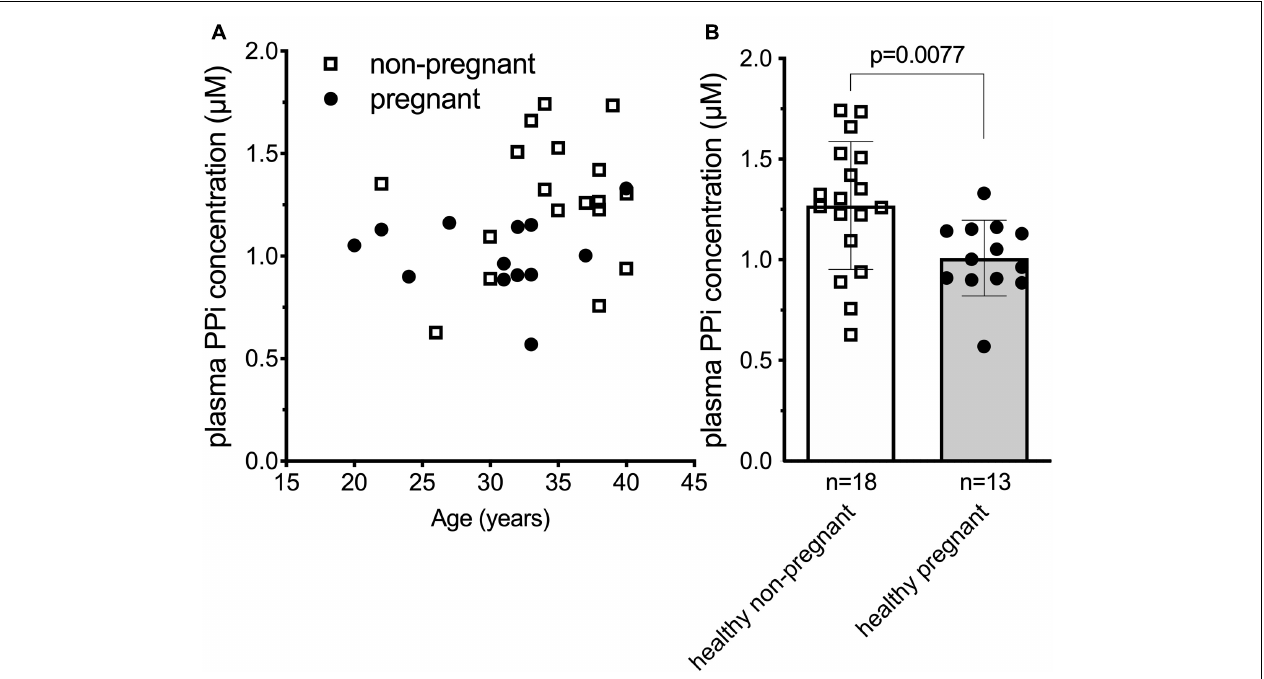
FIGURE 2 | Plasma inorganic pyrophosphate concentration is significantly decreased in uncomplicated human pregnancy. (A) Plasma inorganic pyrophosphate concentration versus age in pregnant ( n = 13, closed circles) and non-pregnant ( n = 18, open squares) healthy women. (B) Plasma inorganic pyrophosphate concentration of healthy pregnant women ( n = 13, closed circles, gray bar) at term versus non-pregnant healthy women ( n = 18, open squares, white bar). Values for the data depicted were determined at least in two independent experiments using at least three technical replicates. Data were analyzed using GraphPad Prism 8.3.0. Data in panel (B) followed normal distribution according to Kolmogorov-Smirnov test. We used unpaired two-tailed t test with Welch’s correction not assuming equal SDs to determine significance. Bars represent means ± SD. Significance was accepted at p < 0.05. PPi, inorganic